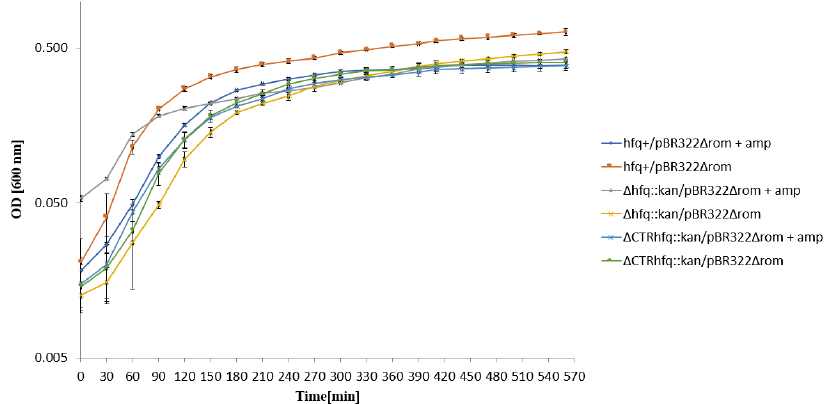
Figure 9. Growth of E. coli strains hfq + , Δ hfq :: kan , and Δ CTR hfq :: kan bearing plasmid pBR322 Δ rom in the LB liquid medium containing 5 mg/mL ampicillin (+amp) or devoid of this antibiotic (no mark) at 37 °C, after transferring bacteria from antibiotic-free LB and diluting the culture 10 times in a fresh LB medium (with or without ampicillin) at time 0. The presented data indicate mean values from three independent experiments with error bars showing SD. Minimal inhibitory concentration (MIC) of ampicillin for hfq + , Δ hfq :: kan , and Δ CTR hfq :: kan hosts bearing pBR322 Δ rom under these conditions was >2048 μ g/mL each strain.